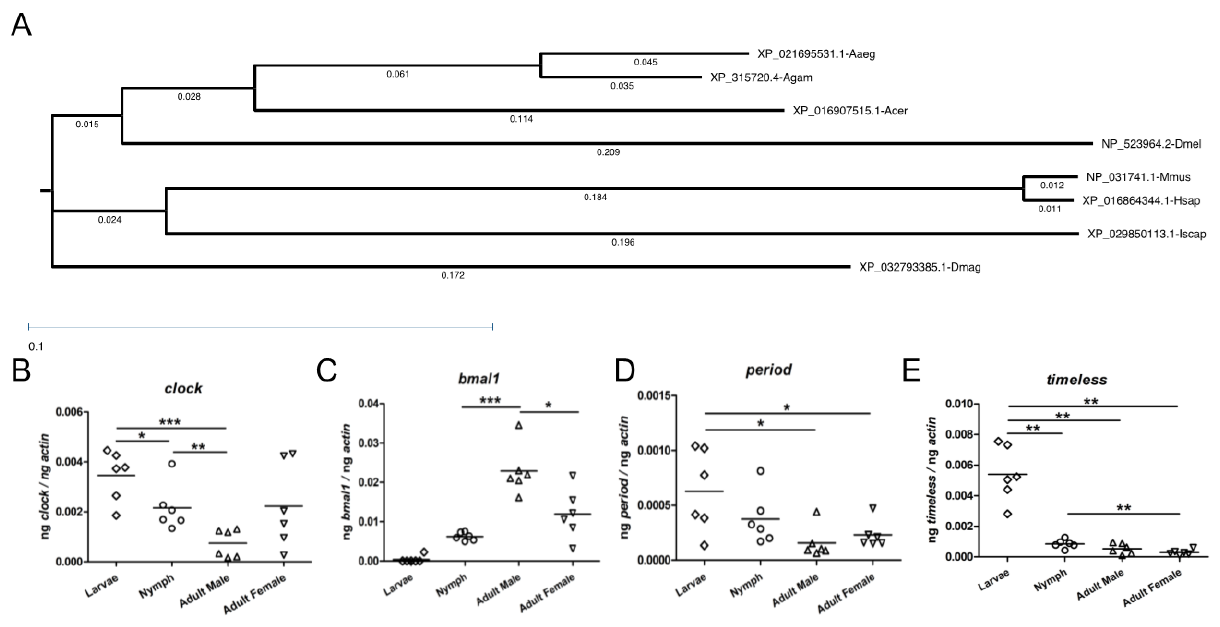
Figure 2. Ixodes scapularis circadian genes have varying expression pattern in tick developmental stages. ( A ) Phylogenetic tree showing relatedness of I. scapularis CLOCK with M. musculus, D. melanogaster, A. gambiae, H. sapiens, A. cerana, Ae. aegypti and D. magna orthologs. The phylogenetic tree was constructed using DNASTAR BIONJ (Neighbor-joining) method. Branch label indicates distance. QRT-PCR analysis showing the levels of I. scapularis clock ( B ); bmal1 ( C ); period ( D ) and timeless ( E ) transcripts in unfed uninfected larvae (open rhombus), nymphs (open circle), adult male (open triangle) and adult female (open inverted triangle). Levels of circadian gene transcripts were normalized to tick beta-actin levels. Each open and closed circle in nymphs and adults represents transcript levels noted in one tick. However, each circle in larvae denotes a sample generated from three pooled larvae. Statistically, a p -value of less than 0.05 was considered significant. * p < 0.05, ** p < 0.01 and *** p < 0.001.